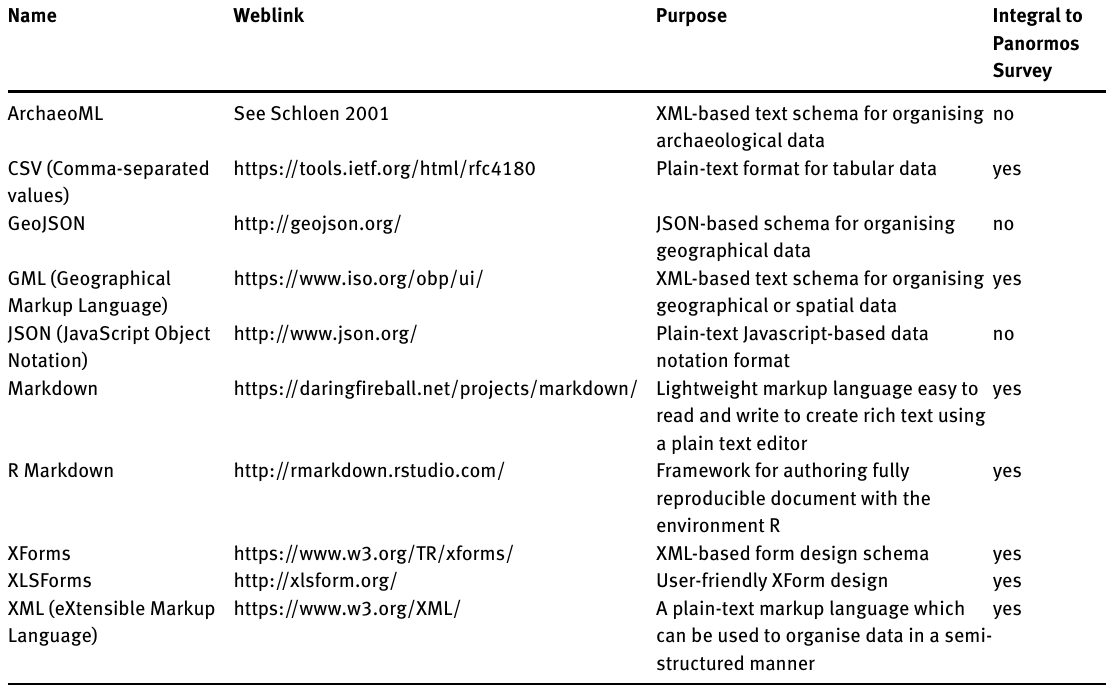
Table 2. Formats and standards.